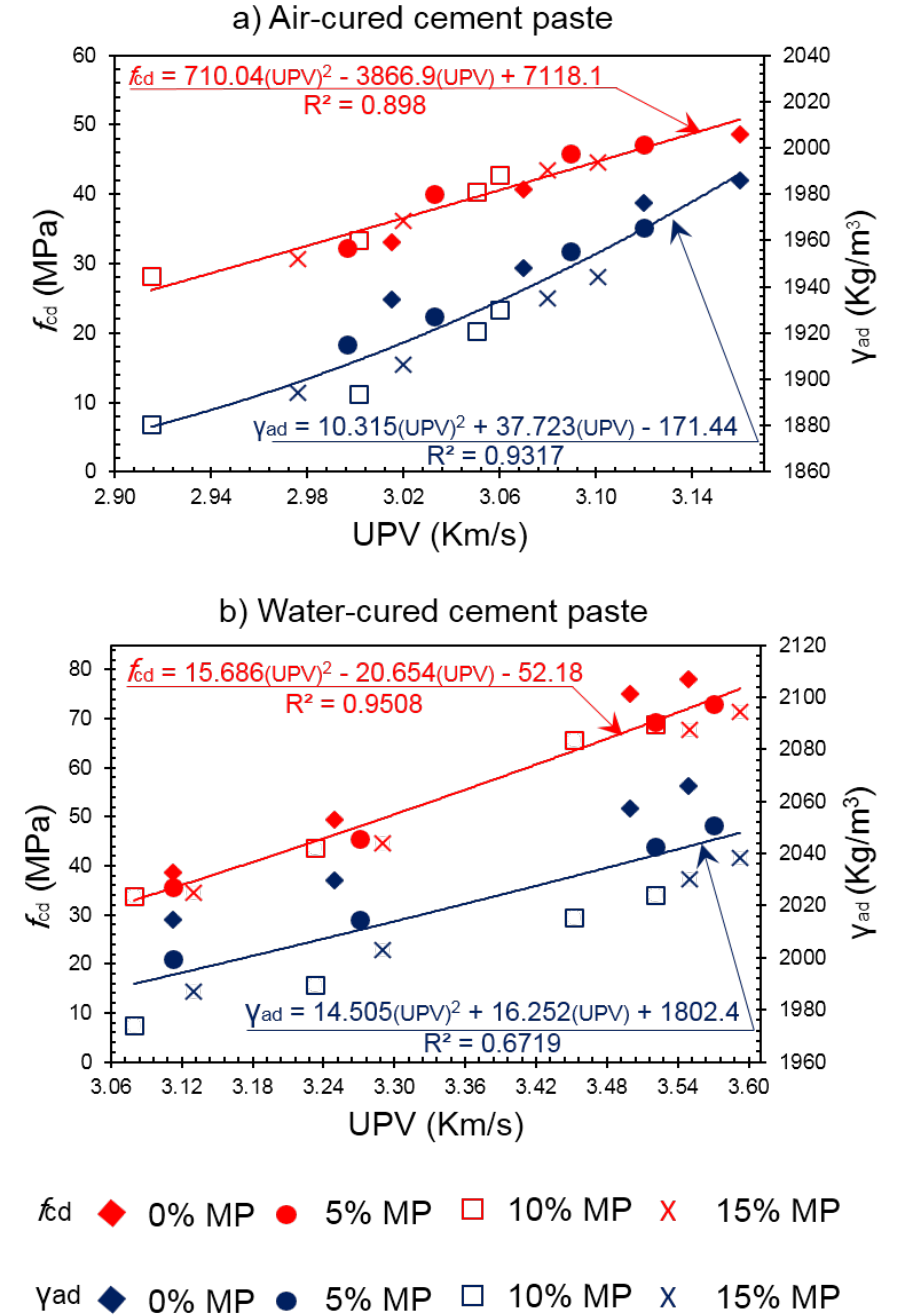
Figure 6. Relationship between compressive strength and UPV, apparent density, and UPV of cement pastes with increasing incorporation levels of MP, at 3 to 65 days, ( a ) air-cured cement paste; ( b ) water-cured cement paste.